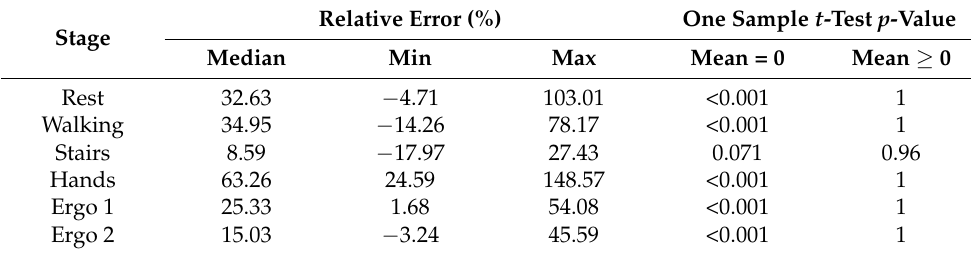
Table 1. Results of individual